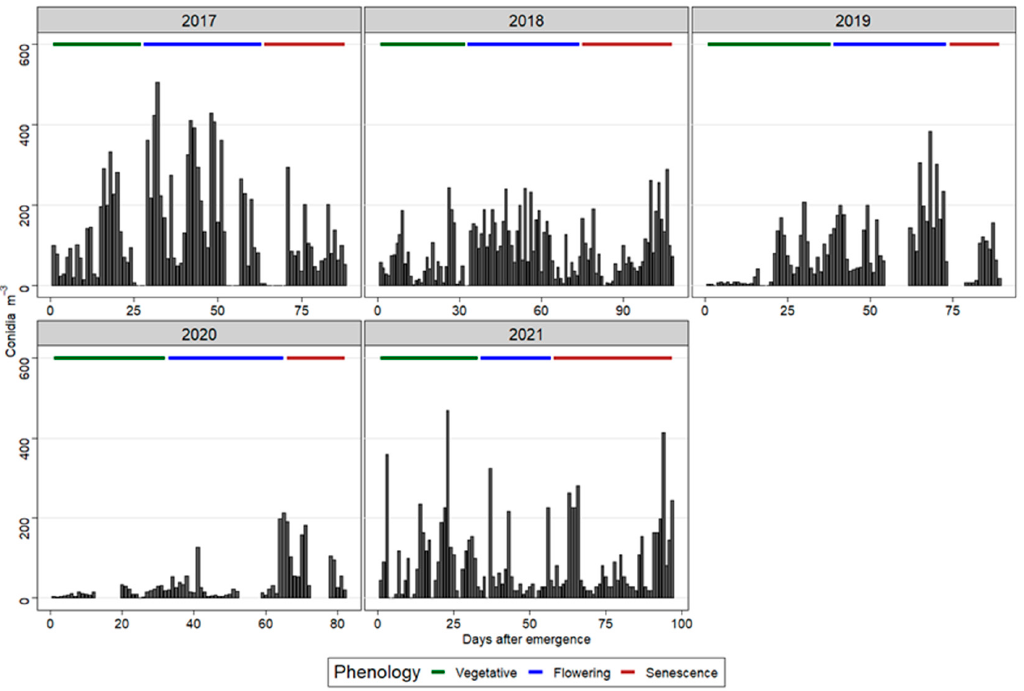
Figure 2. Daily conidia concentrations and phenological stages (vegetative, flowering, and senes- cence) in different cropping seasons. The emergence dates were 16 May 2017, 1 June 2018, 4 June 2019, and 10 June (2020 and 2021) (Table